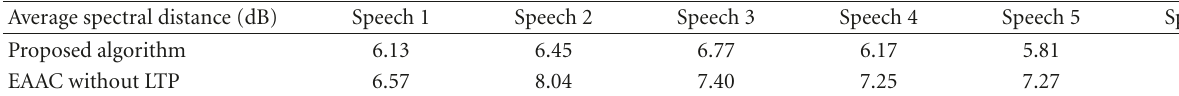
Table 4: Average spectral distance of speech signal.